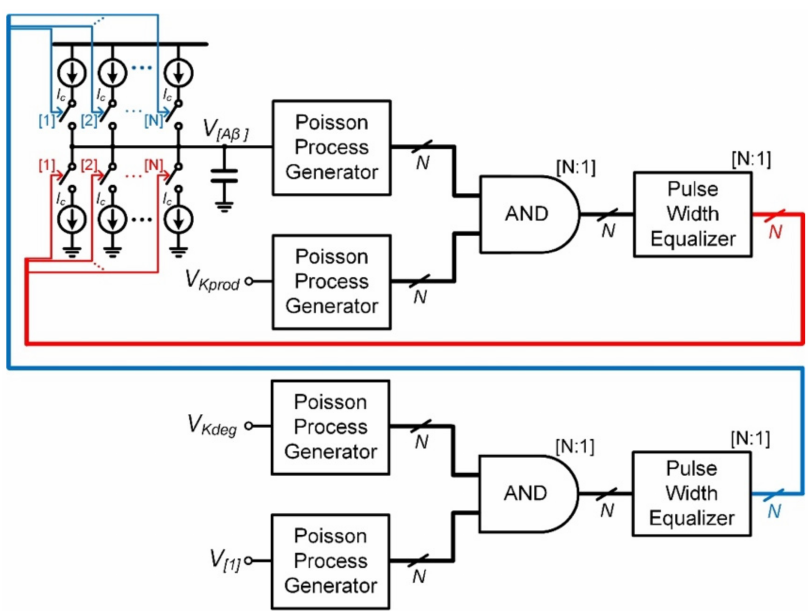
Figure 7. Fundamental reaction building block for stochastic simulation of the model of amyloid beta (A β )